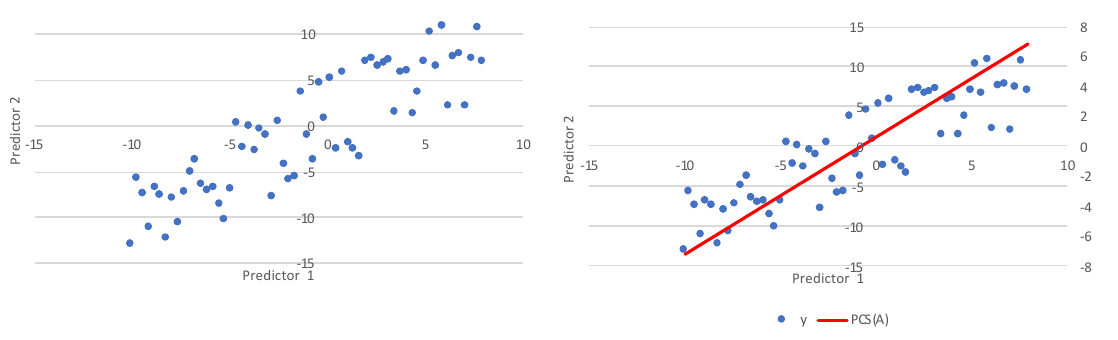
Figure 1. Principle of the PCA method